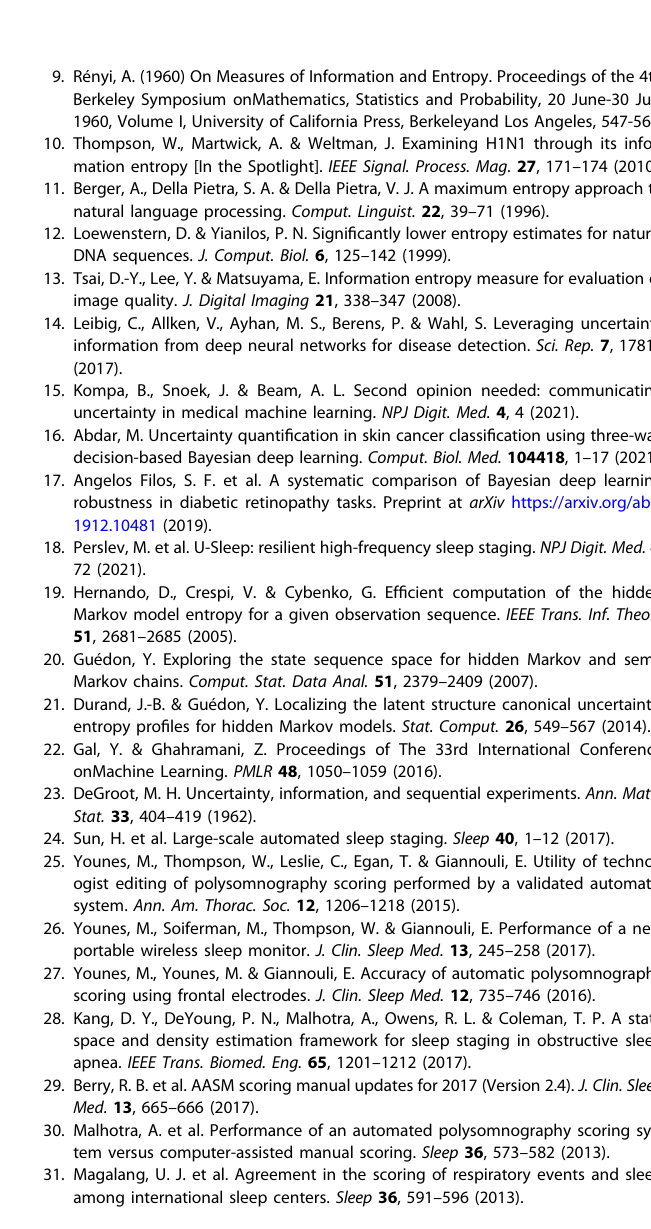
Fig. 5 Hypnogram generation for an individual. a Hypnogram based on full-PSG and manual scoring for an HN subject (AHI < 5). b Automated hypnogram and epochs threshold and targeted for manual review. K = 0.70, 18% of study to review. c Automated hypnogram after manual review of uncertain epochs. K =